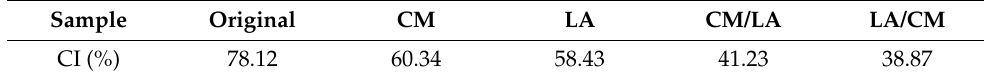
Table 1. The crystallinity index data.